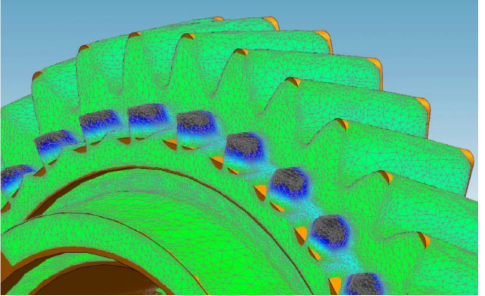
Figure 8. Load distribution on the contact surfaces of the teeth.